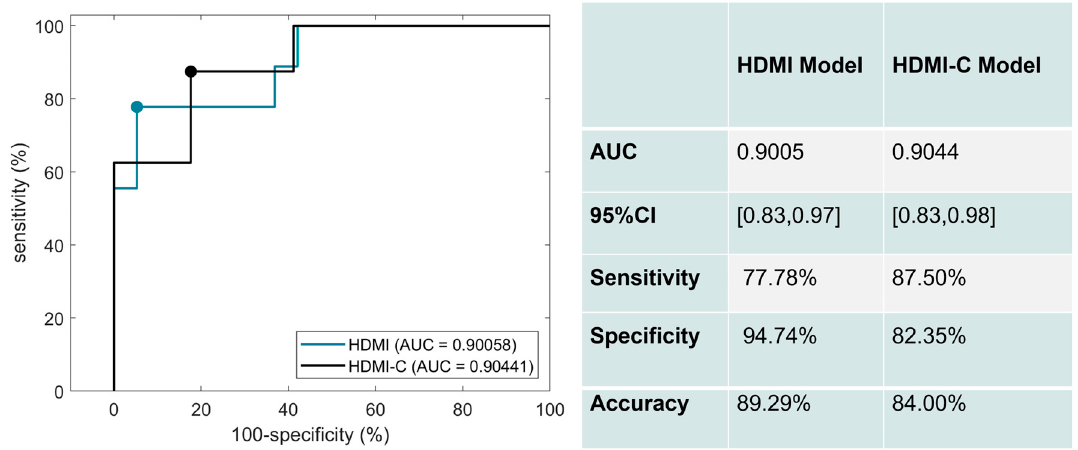
Figure 4. ROC curves generated using the HDMI biomarkers (blue) and HDMI biomarkers combined with clinical data (black).